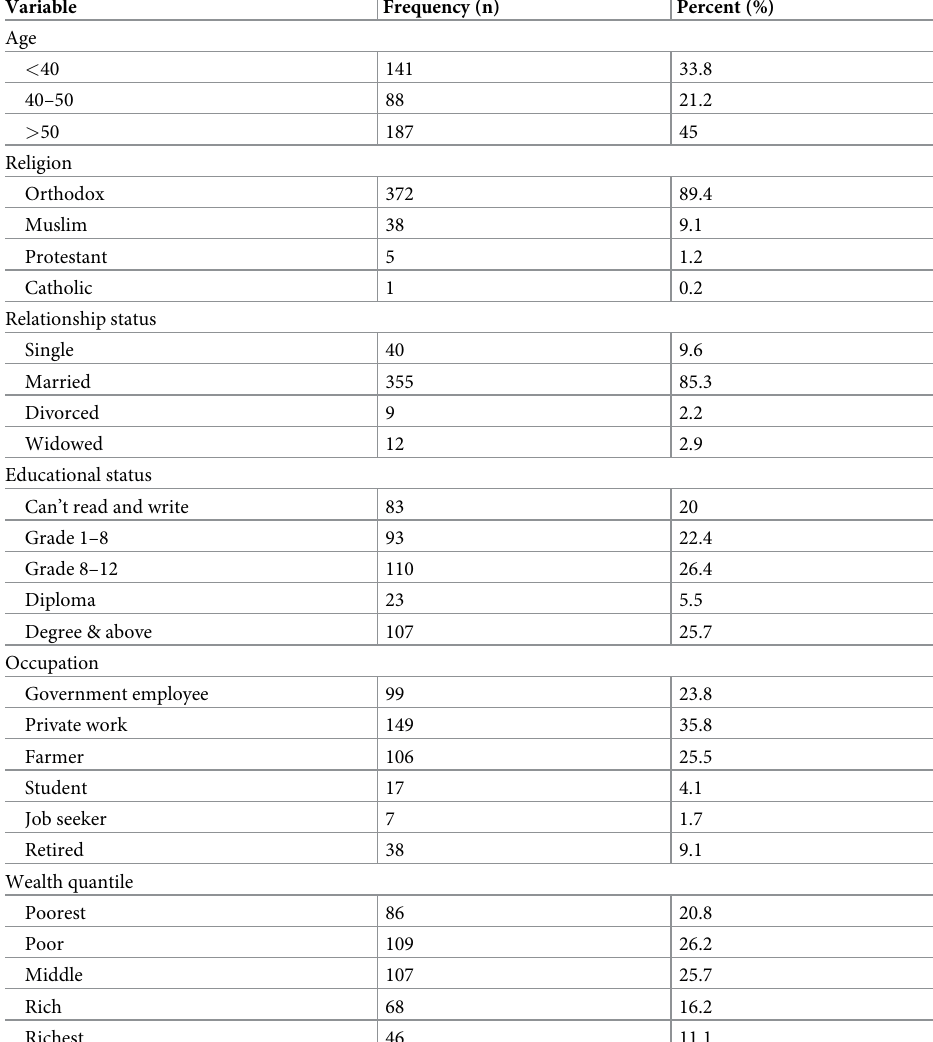
Table 1. Socio-demographic characteristics of men with diabetes at the three hospitals of Northwest Amhara region, Ethiopia from February 20–April 15, 2020 (n = 416).